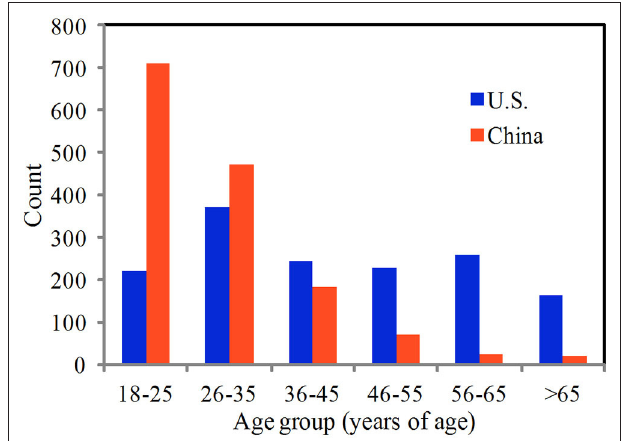
FIGURE 1 | Age group distribution of survey participants. The U.S. cohort ( N = 1,547) was more or less evenly distributed whereas the Chinese cohort ( N = 1,732) consisted of proportionally more people in the younger range of